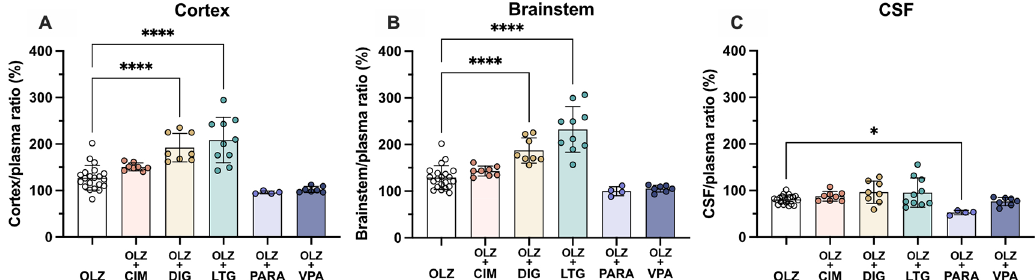
Figure 9. Entry of [ 3 H]-olanzapine into the E19 rat. (A) Brain cortex, (B) brainstem and (C) cerebrospinal fluid (CSF) after a single intravenous ( i.v. ) injection either as monotherapy or in combination with: cimetidine (11 mg/kg), digoxin (DIG, 0.03 mg/kg), lamotrigine (LTG, 6 mg/kg), lithium (Li, 3.2 mg/kg), paracetamol (PARA, 15 mg/kg) or valproate (VPA, 30 mg/kg). Bars are means (cid:3) SD. Note each point is an individual animal (n=4 – 21). *p<0.05,